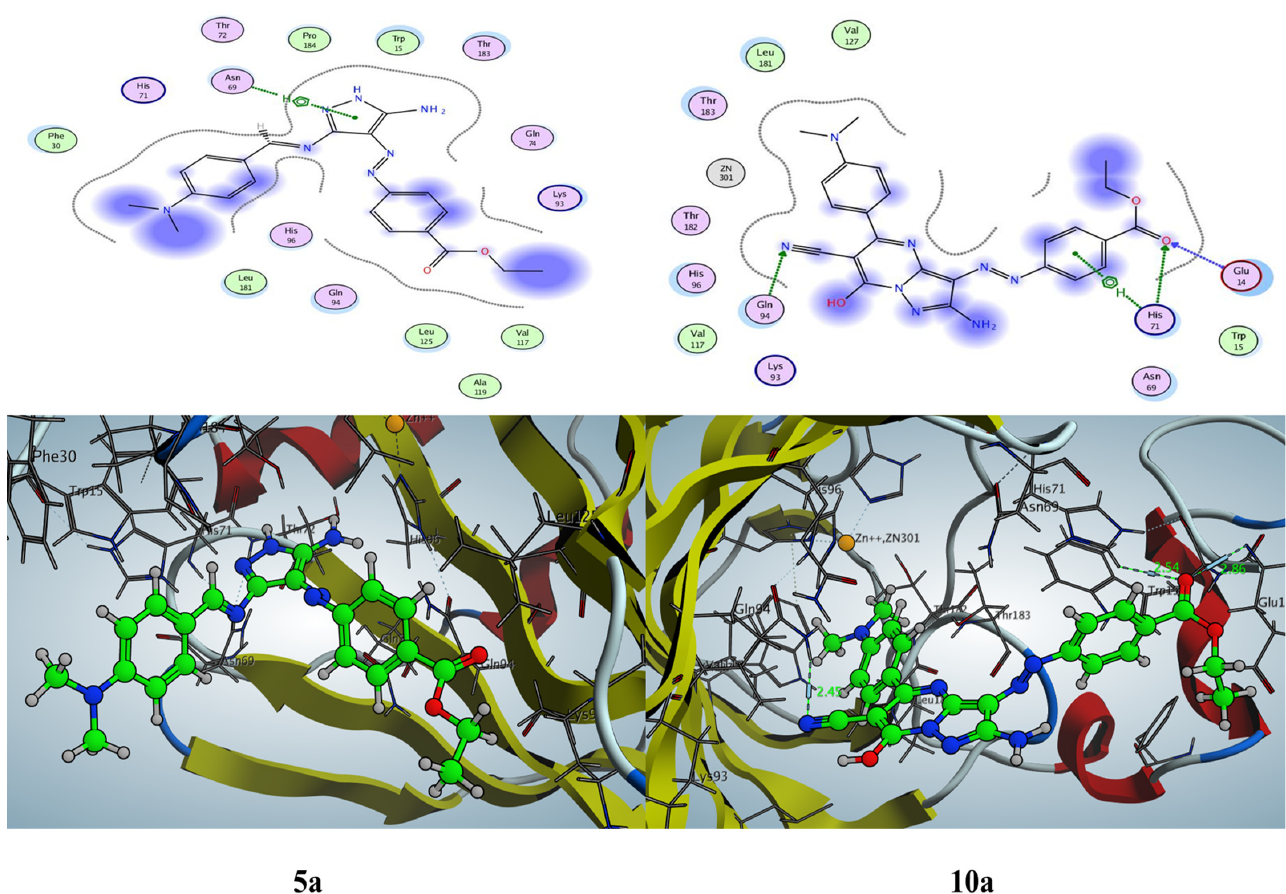
Figure 14. 2D and 3D enzyme–ligand interaction of compounds 5a and 10a inside the active site of alpha CA (PDB: 5HPJ) .